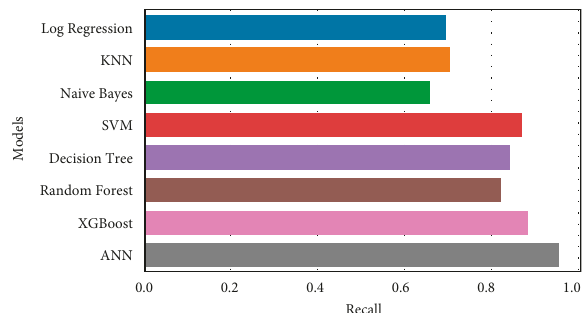
Figure 9: Comparative analysis of recall using different prediction models.